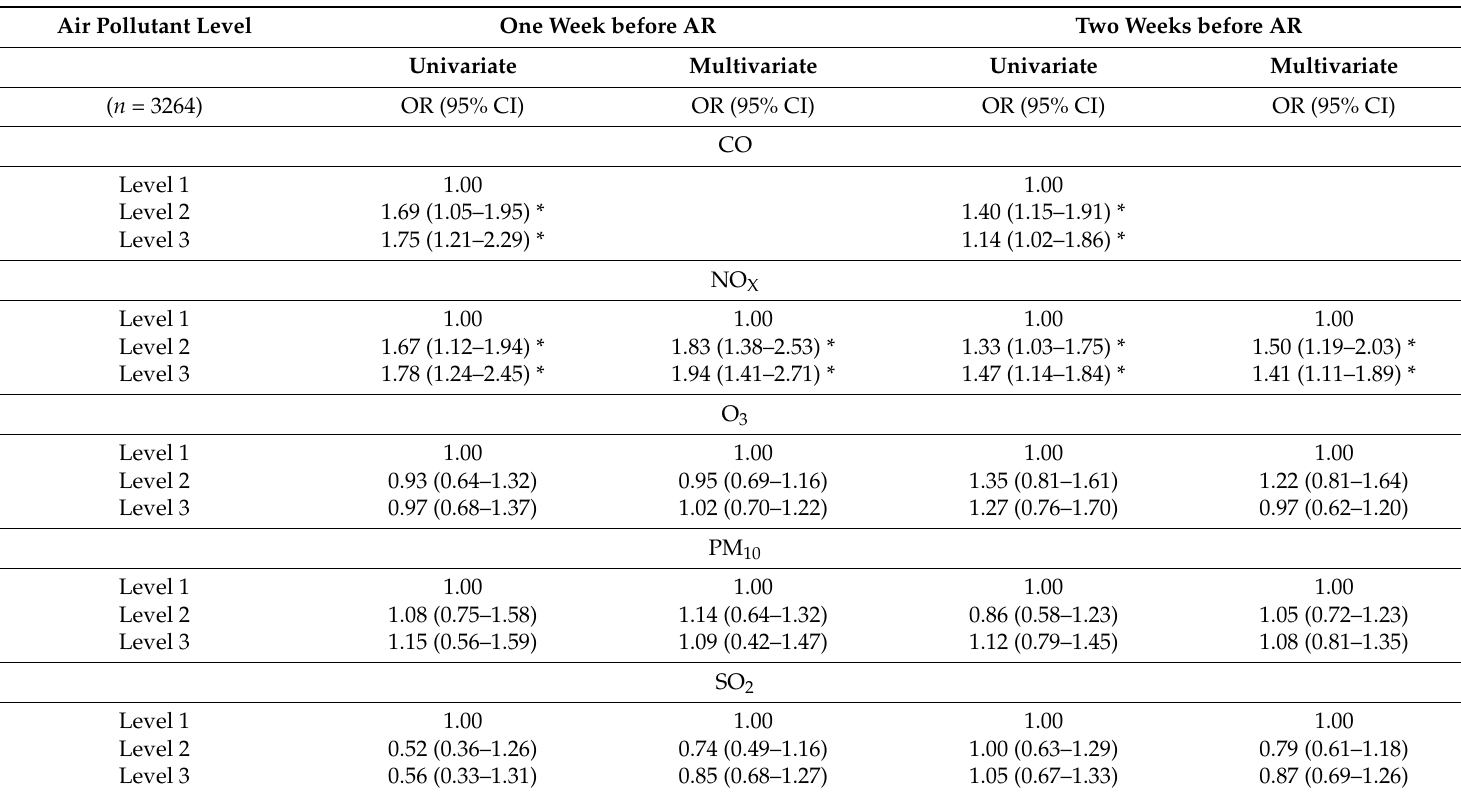
Table 4. Uni- and multivariate logistic regression analyses between AR occurrence and different pre-incident levels of air pollutants after adjustment for age and